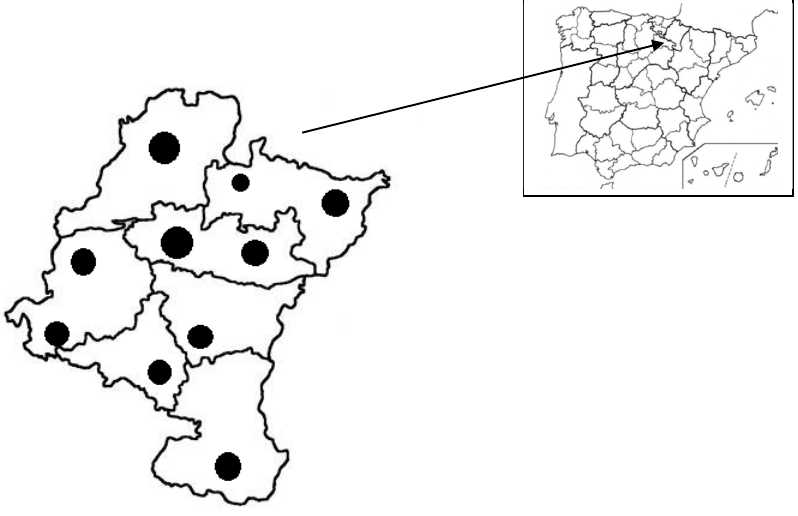
Figure 1. Territorial distribution of research participants.